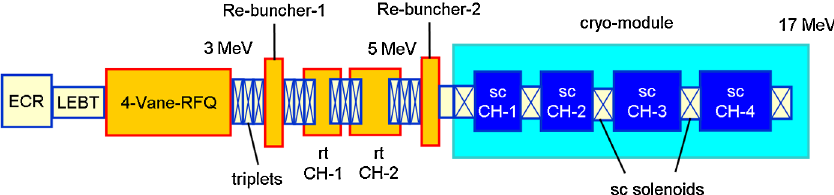
[18]).FIG. 11. (Color) Layout of the 17 MeV EUROTRANS front